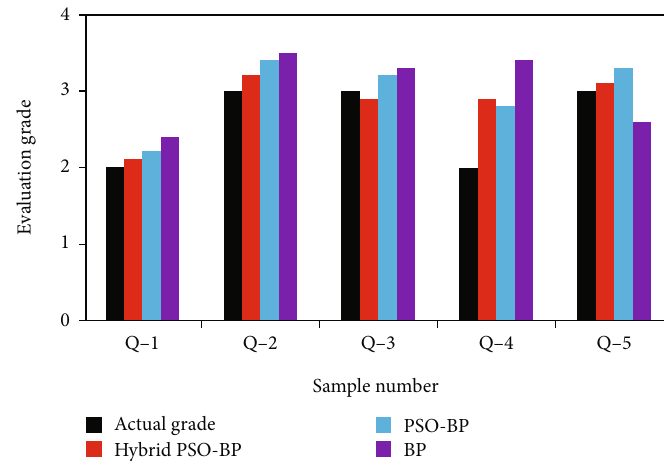
Figure 2: Comparison of model